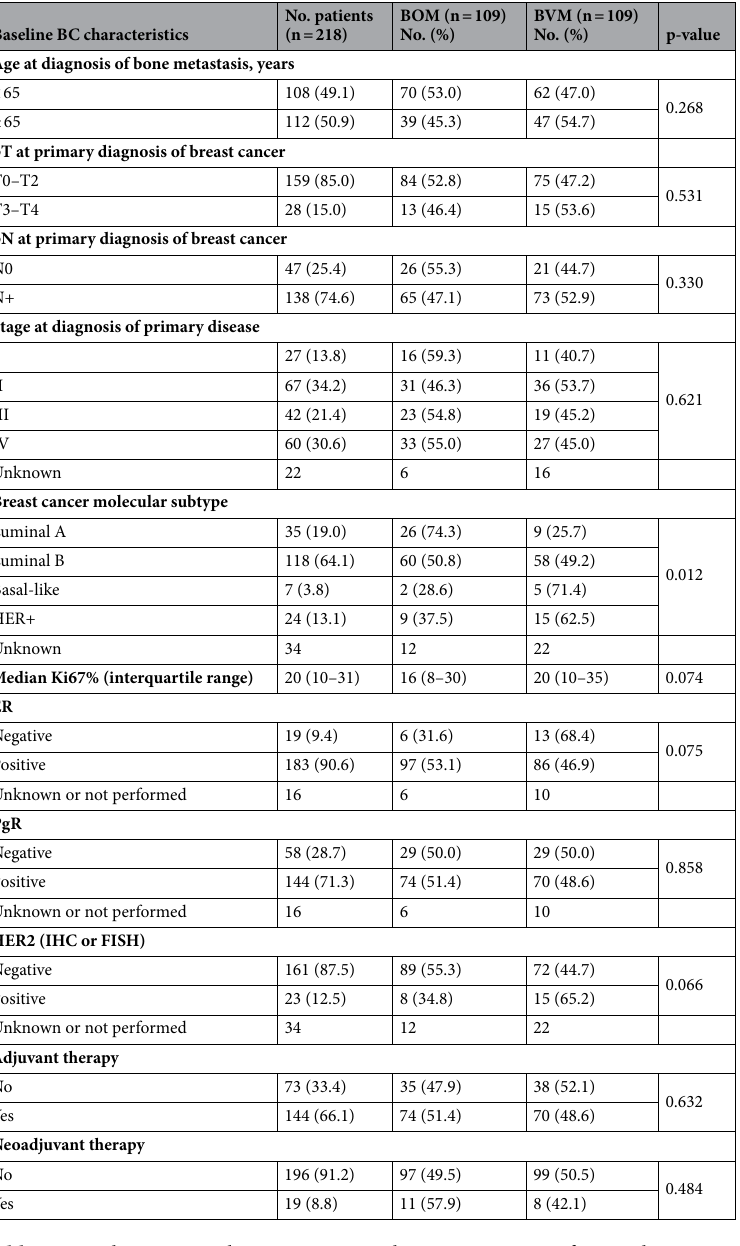
Table 3. Baseline patient characteristics in relation to presence of visceral metastases. BC breast cancer, BOM bone-only metastasis, BVM visceral and bone metastasis, pT primary tumour, pN pathological lymph